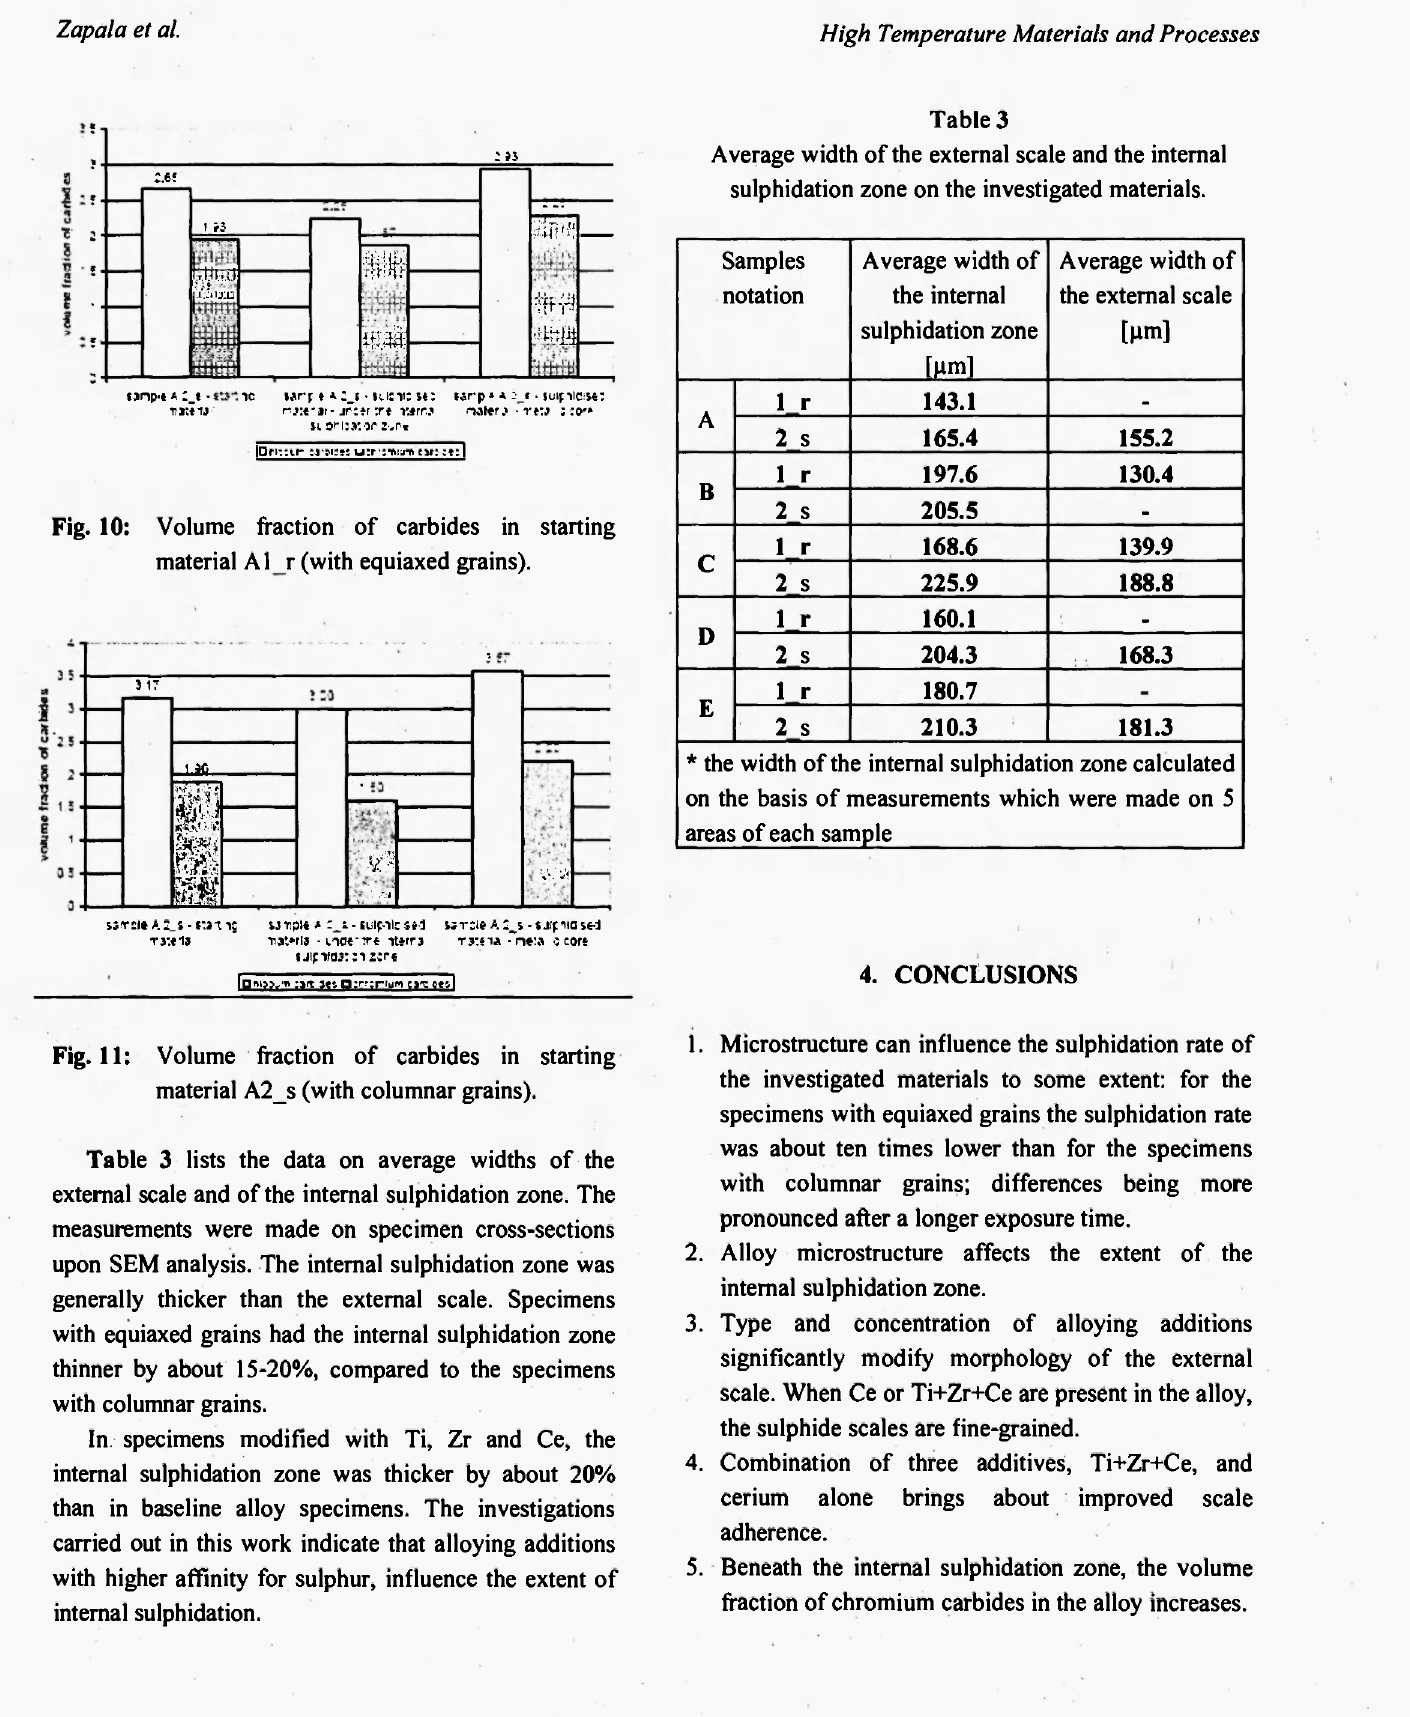
adherence. 5. Beneath the internal sulphidation zone, the volume fraction of chromium carbides in the alloy